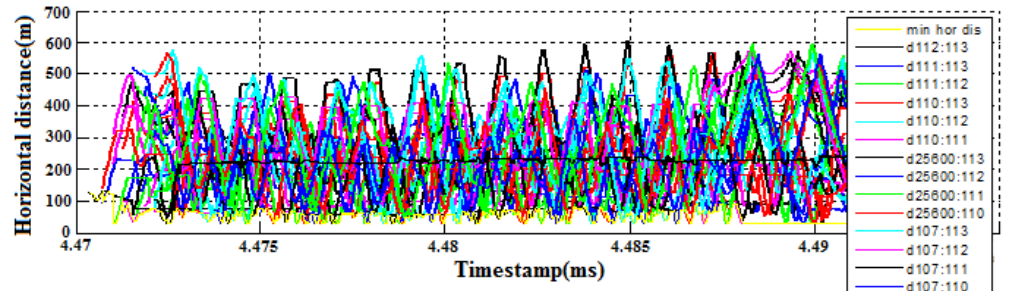
Figure 24. HILS: Separation distance from UAV to